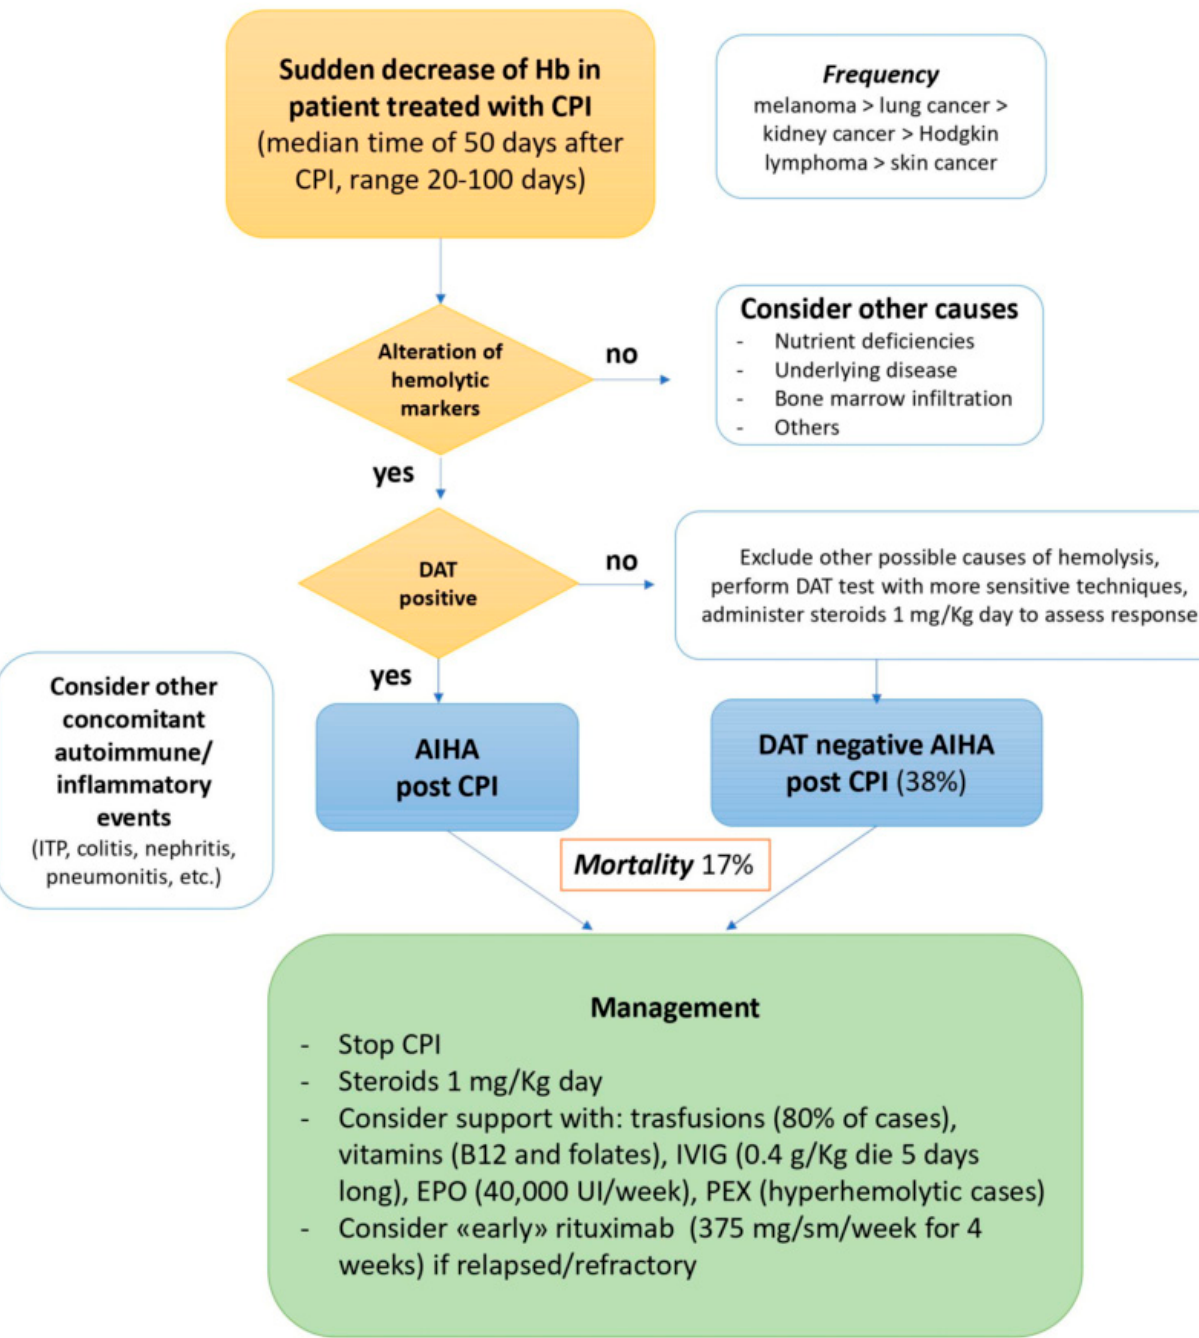
Figure 1. Diagnosis and management of patients affected by autoimmune hemolytic anemia (AIHA) after checkpoint inhibitors (CPI). DAT direct antiglobulin test; ITP immune thrombocytopenia; IVIG intravenous immunoglobulin; EPO recombinant human erythropoietin; PEX plasma exchange.